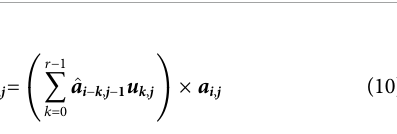
Frontiers in Energy